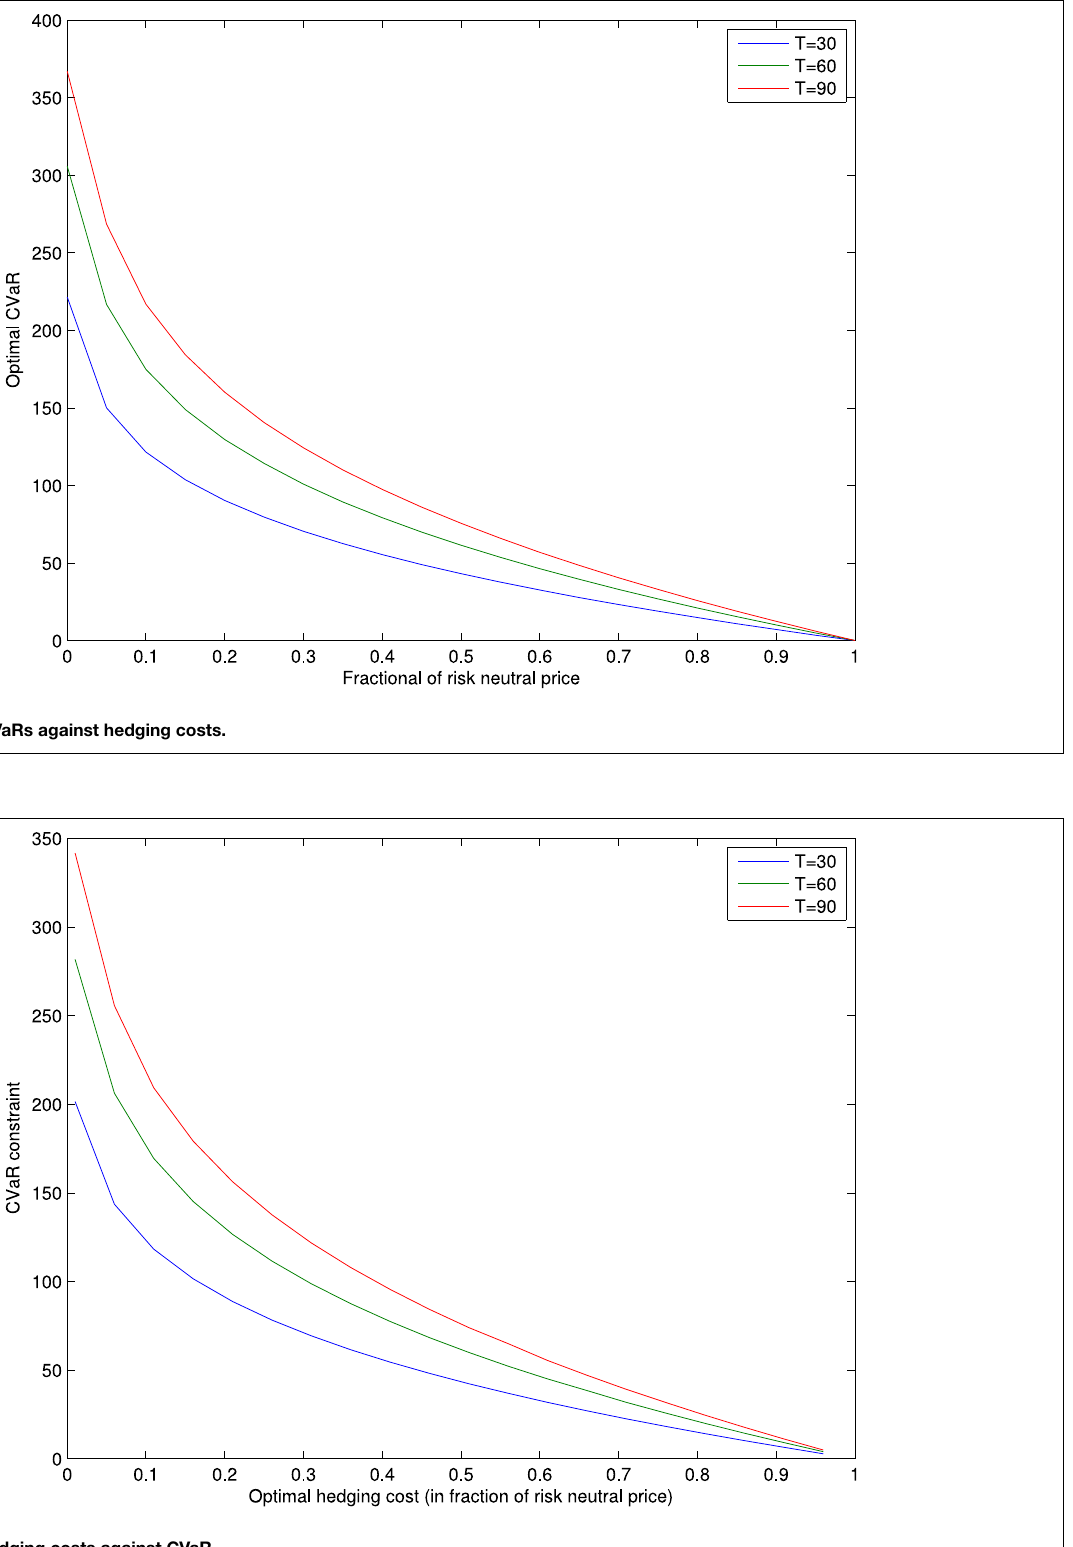
FIGURE 2 | Optimal hedging costs against